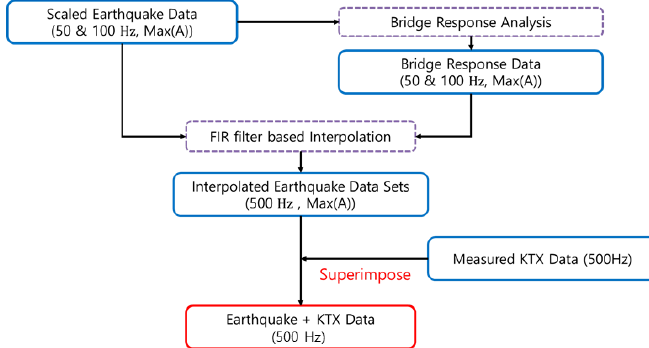
Figure 20. Data -sy nthesis flowchart. Figure 20. Data-synthesis